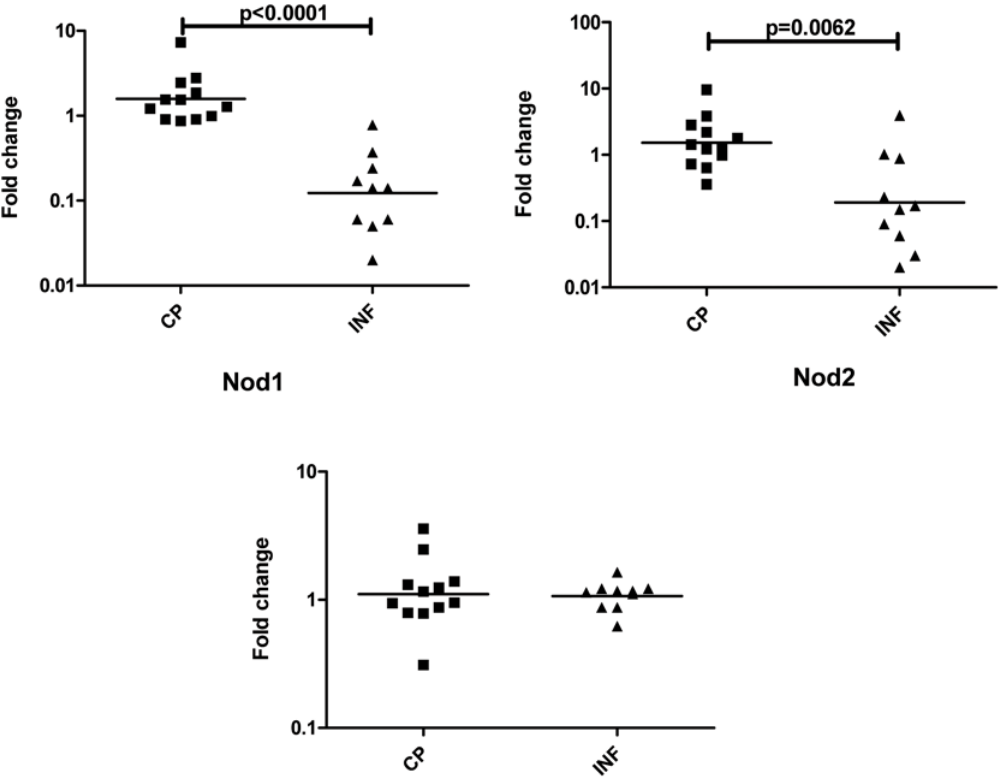
Figure 6. Filarial lymphedema is associated with increased expression of Nod1 and Nod2 mRNA. PBMCs from filarial lymphedema [CP] (n=12) and asymptomatic infected [INF] (n=10) patients were stimulated with BmA (10 m g/ml) for 24 hours, and Nod1, Nod2 and NALP3 mRNA were measured by real-time RT-PCR. Results are shown as fold change over media control. P values were calculated using the Mann-Whitney test.